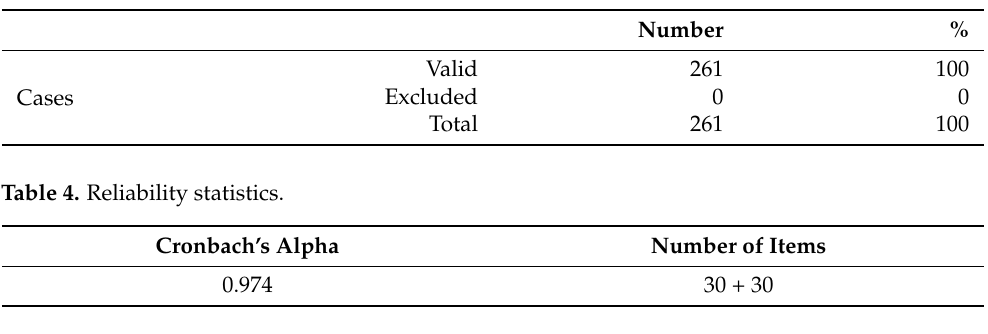
Table 3. Validity statistics.